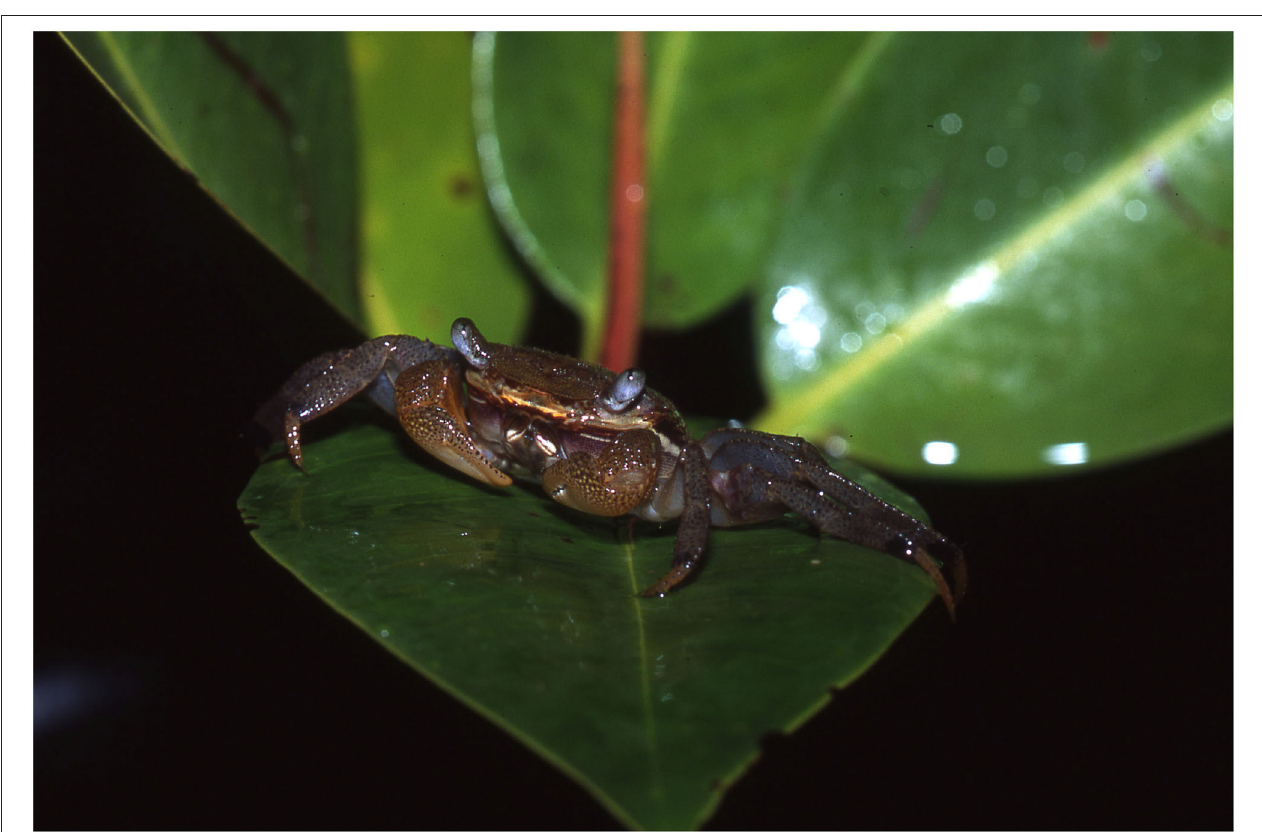
FIGURE 1 | The Sri Lankan tree climbing crab Perisesarma dussumieri , here on a Rhizophora apiculata mangrove tree. The invertebrate faunal community in Sri Lankan mangroves has an extremely high level of functional vulnerability, suggesting a potentially rapid decrease of functional diversity ( Cannicci et al.,